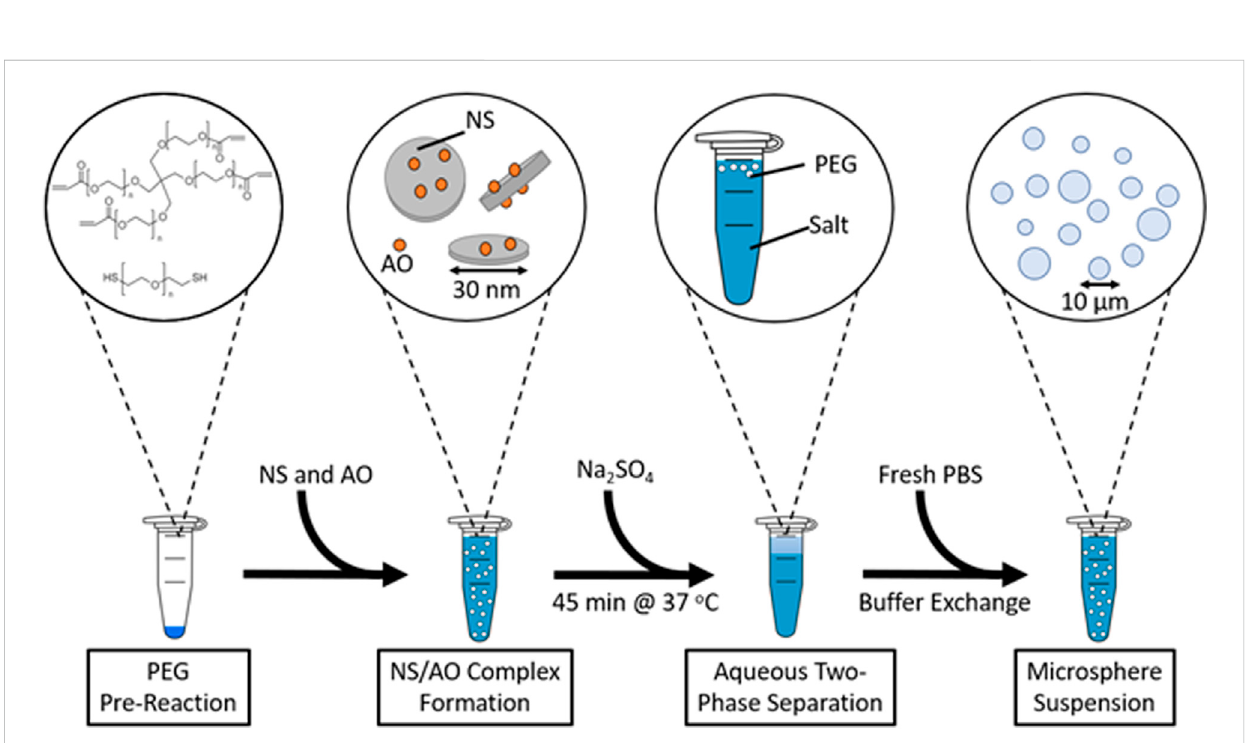
FIGURE 1 Schematic depicting the fabrication of PEG and PEG-NS-AO microspheres by aqueous two-phase